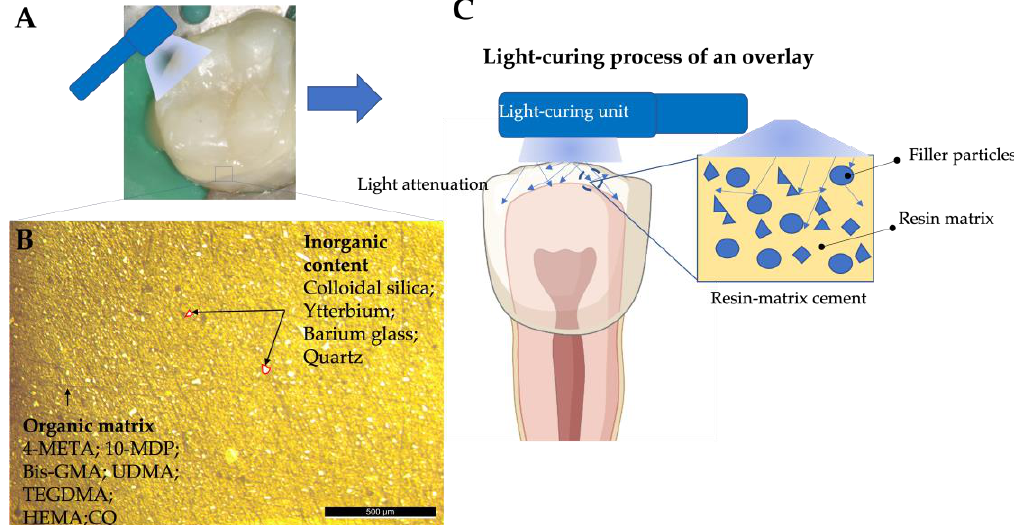
Figure 2. A — Overlay cementation; B — Optical microscope image, 50× magnification, showing the Figure 2. A —Overlay cementation; B —Optical microscope image, 50 × magnification, showing the organic matrix and the inorganic content; C — Schematics of light scattering. organic matrix and the inorganic content; C —Schematics of light